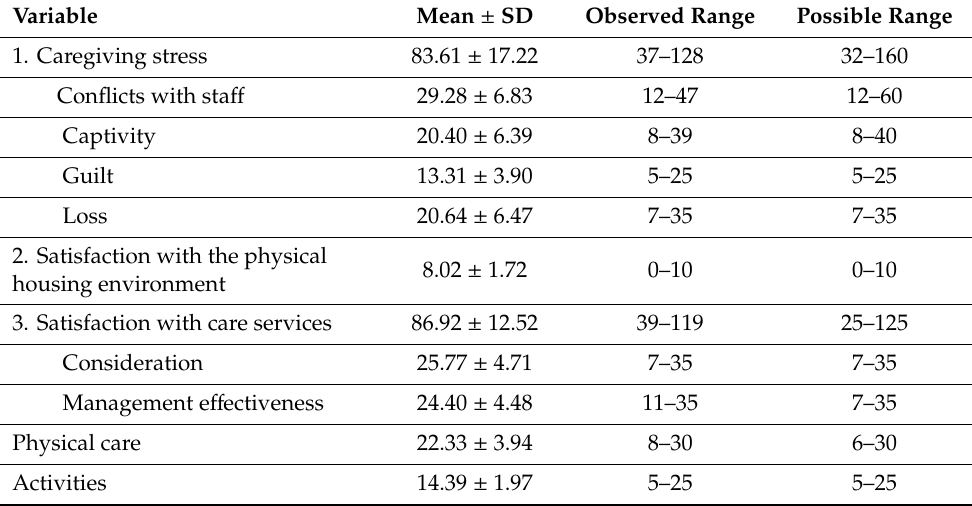
Table 4. Descriptive statistics for measured variables, N = 330.